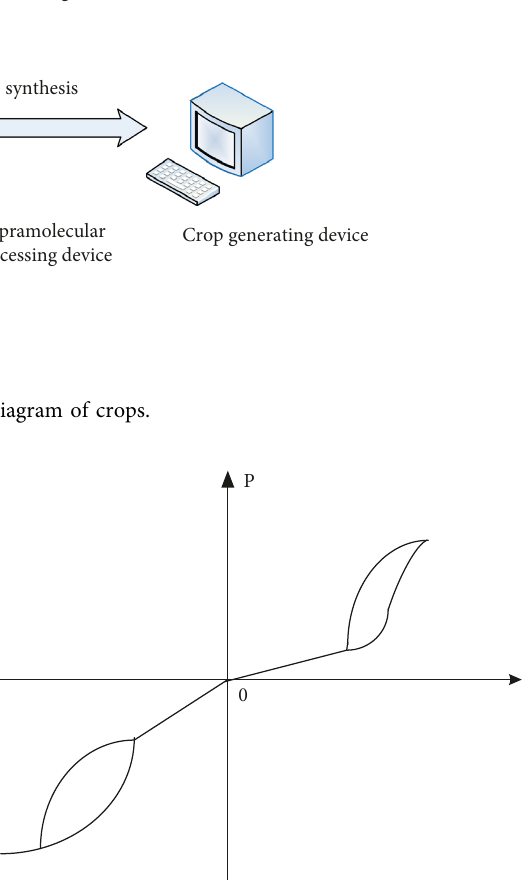
Figure 2: Double electric hysteresis loop of antiferroelectric